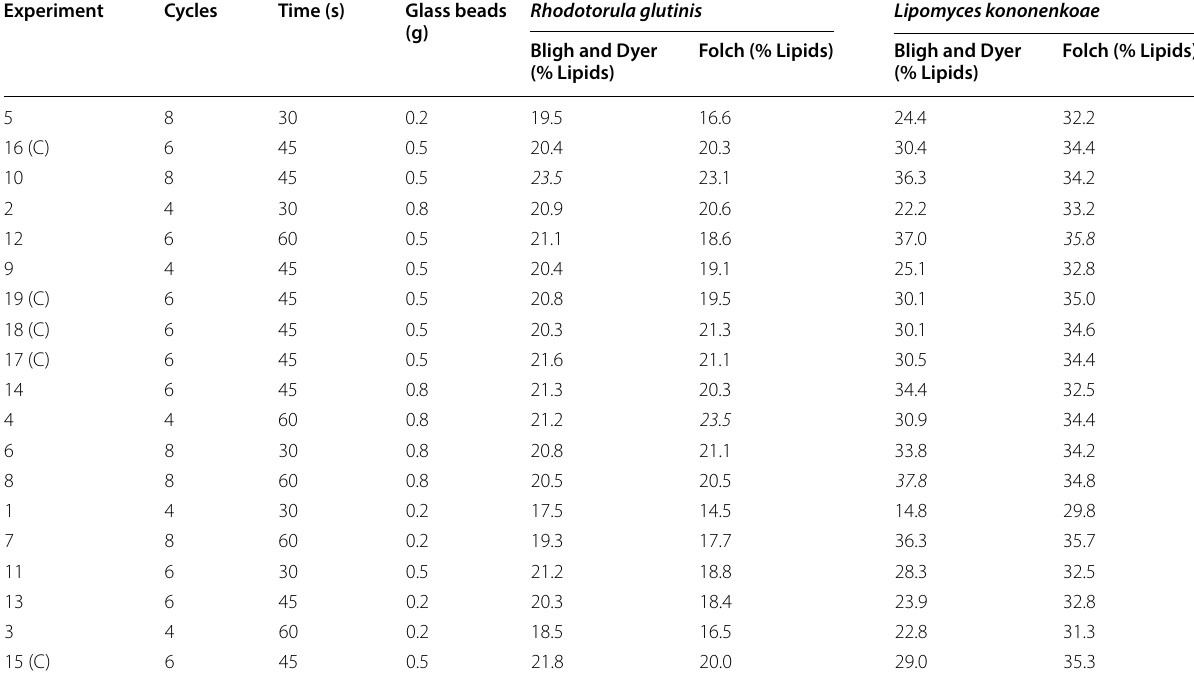
Table 2 Lipid extraction yield for each experiment for Rhodotorula glutinis and Lipomyces kononenkoae using Bligh and Dyer and Folch extraction methods Experiment